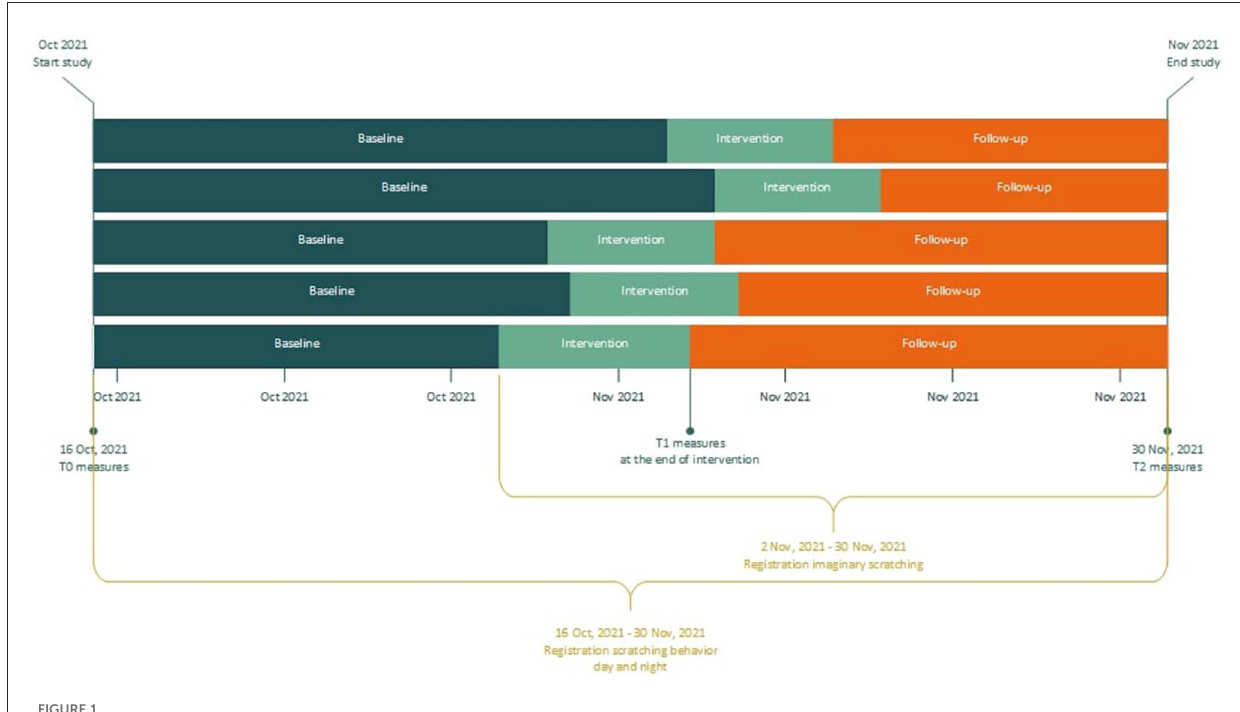
FIGURE1 Flowchart of study